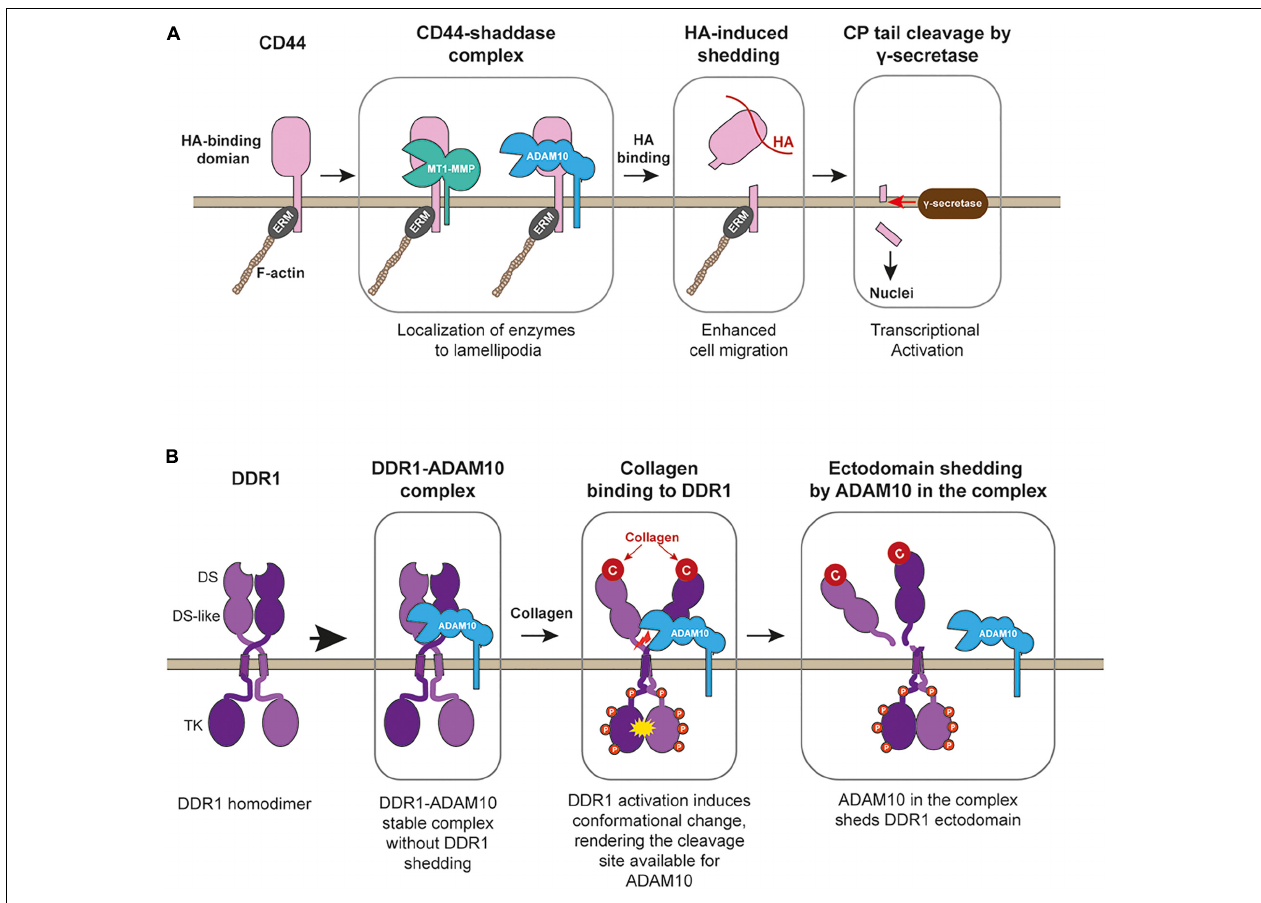
FIGURE 3 | CD44 processing and collagen-induced shedding of DDR1 by ADAM10. (A) CD44 forms stable complex with MT1-MMP (or potentially with ADAM10), allowing the enzymes to localize at lamellipodia. Upon binding to HA-substratum at the leading edge, the enzyme in the complex shed the ectodomain of CD44, releasing CD44-mediated cell adhesion and promote cell migration. After ectodomain removal, γ -secretase releases the cytoplamic tail of the CD44, and released cytoplasmic tail acts as a transcriptional factor to stimulate gene expression. ERM, band 3.1 proteins. (B) DDR1 upon secretion forms a stable complex with ADAM10, but ADAM10 does not cleave DDR1. Collagen binding activates DDR1 and induces conformational change in its ectodomain, rendering the cleavage site available to ADAM10. ADAM10 cleaves between Pro407-Val408 at the juxtamembrane region to release DDR1-dependent cell adhesion and to stop collagen signaling through